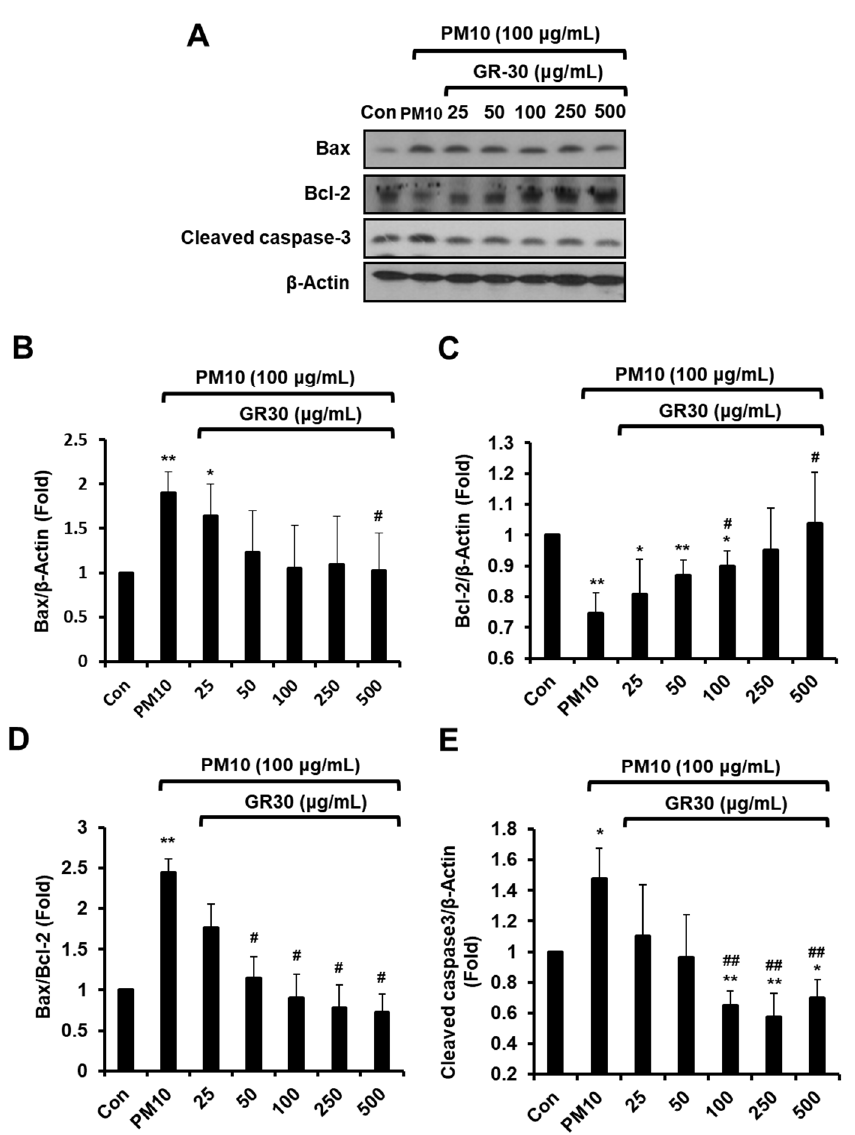
Figure 3. GR30 antagonizes PM10-induced apoptotic cell death via mitochondria-dependent apoptosis in RBL-2H3 cells. ( A ) Expressions of Bax, Bcl-2, and cleaved caspase-3 were examined by Western blot analysis using β -actin as a loading control. Protein levels of ( B ) Bax, ( C ) Bcl-2, and ( E ) cleaved caspase-3 were quantified by densitometric analysis, and the ( D ) Bax/Bcl-2 ratio was determined. The data are expressed as the fold normalized to the untreated control (Con). Each value was presented as the means ± SD ( n = 3). *, p < 0.05; **, p < 0.01, compared to the control cells (Con). #, p < 0.05; ##, p <0.01, compared to the PM10 ‐ treated cells (PM10).